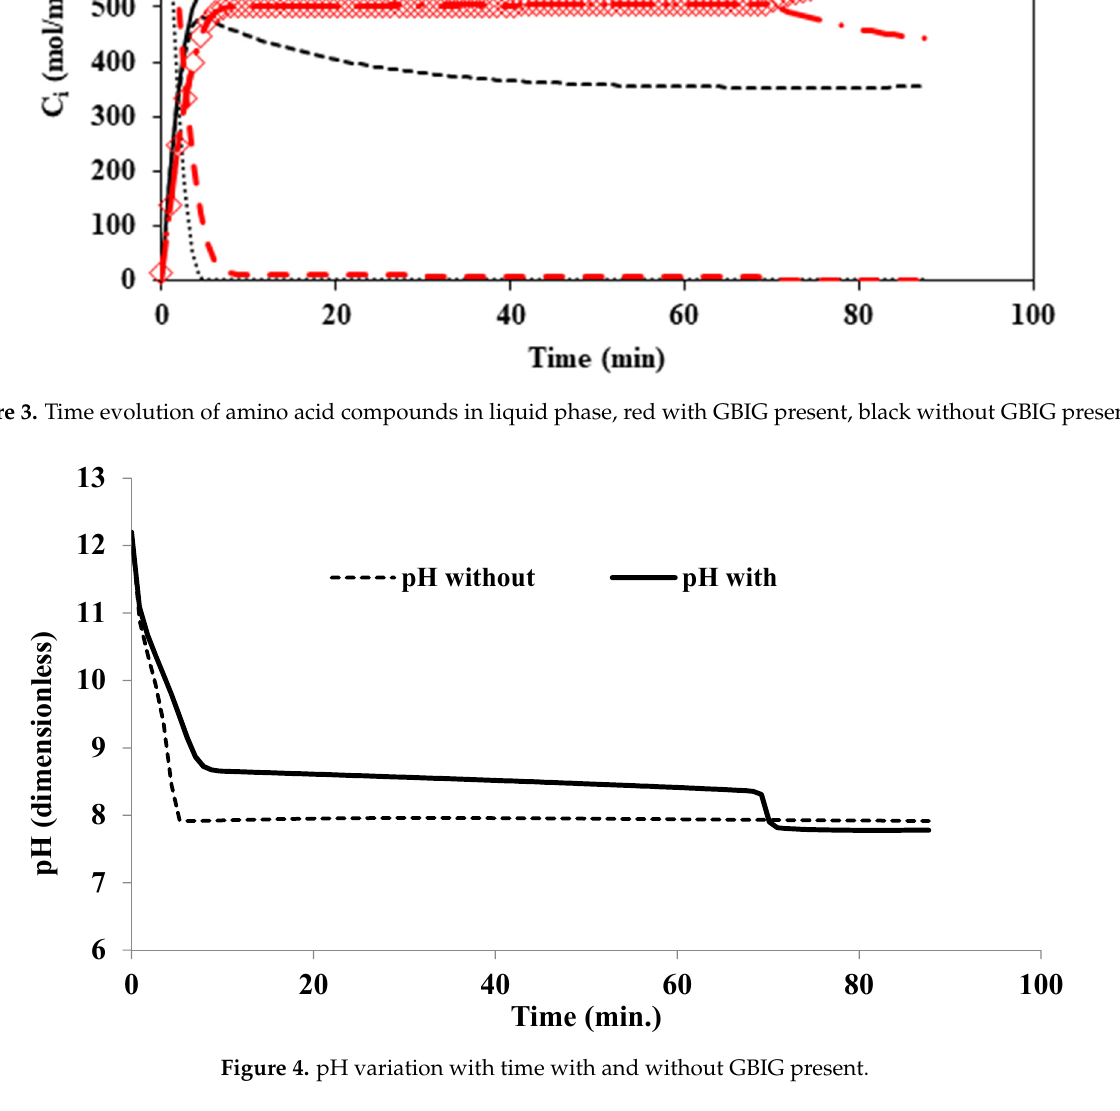
Figure 4. pH variation with time with and without GBIG present.